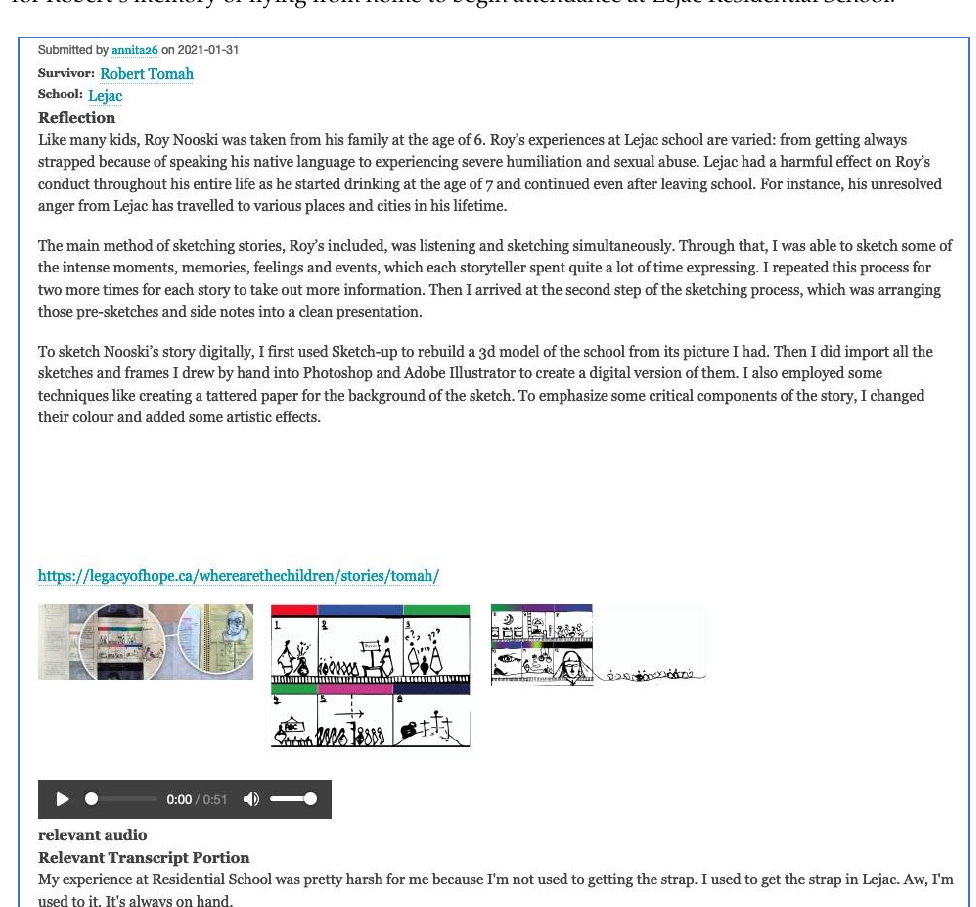
Figure 10. Screenshot of the Mapping Survivor Stories Map showing a full document view.